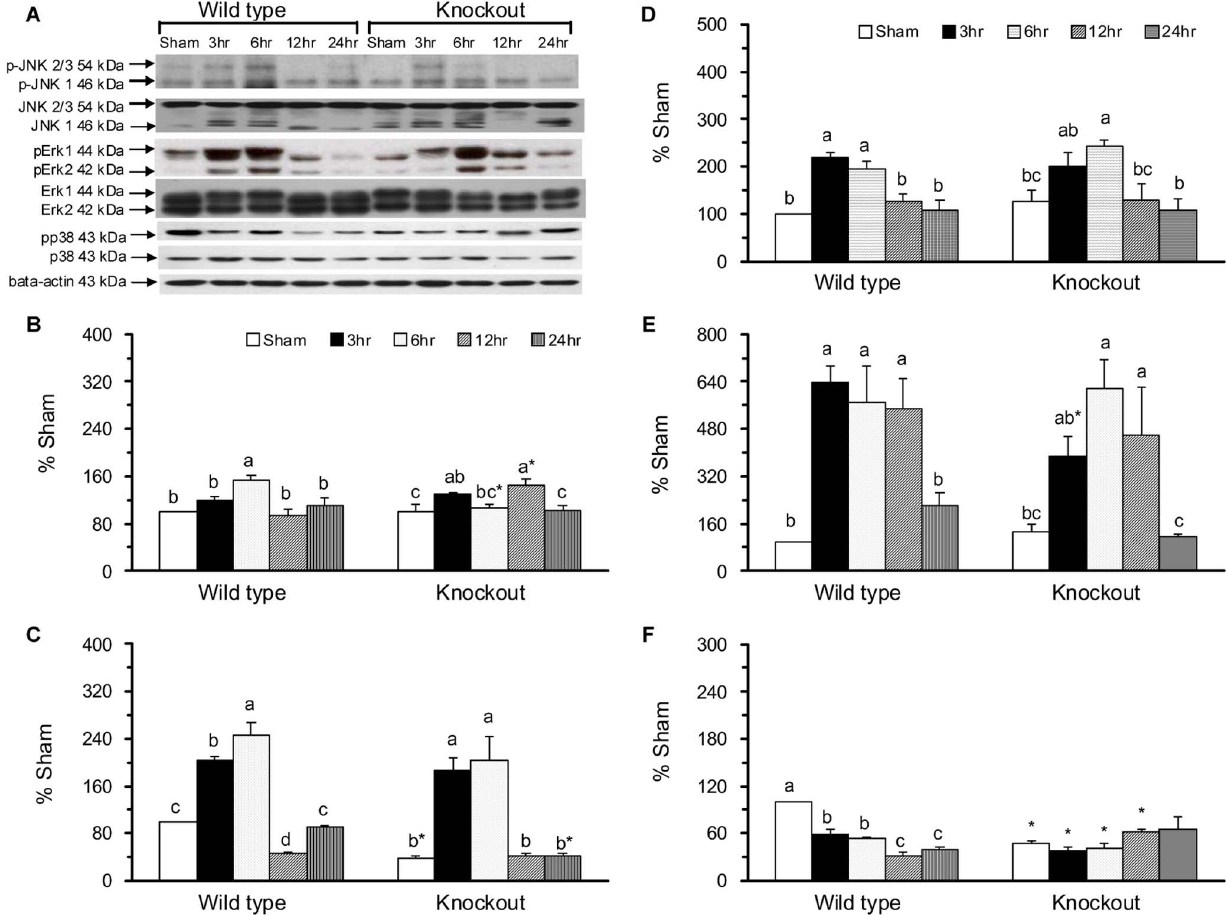
Figure 5. Molecules of the mitogen-activated protein kinases (MAPK) signaling pathway in the jejunum. A western blot assay to detect the protein expression of total and phosphorylated JNK, ERK, and p38 and the internal control b -actin (A). Protein expression of phosphorylated JNK1 (B), phosphorylated JNK 2/3 (C), phosphorylated ERK1 (D), phosphorylated ERK2 (E), and phosphorylated p38 (F). Protein quantification was carried out by densitometric analysis, normalized by the internal control b -actin, and calculated as the percentages of the WT-SH group. Means 6 SEM, n=10 for the WT groups and n=9 for the KO groups. *P , .05, KO vs. WT mice with sham operation or with intestinal IR at the same time point (Student’s t- test,). Values with different superscripts indicate significant differences within all of the time points in WT and KO mice, individually (one-way ANOVA with LSD, P , .05).